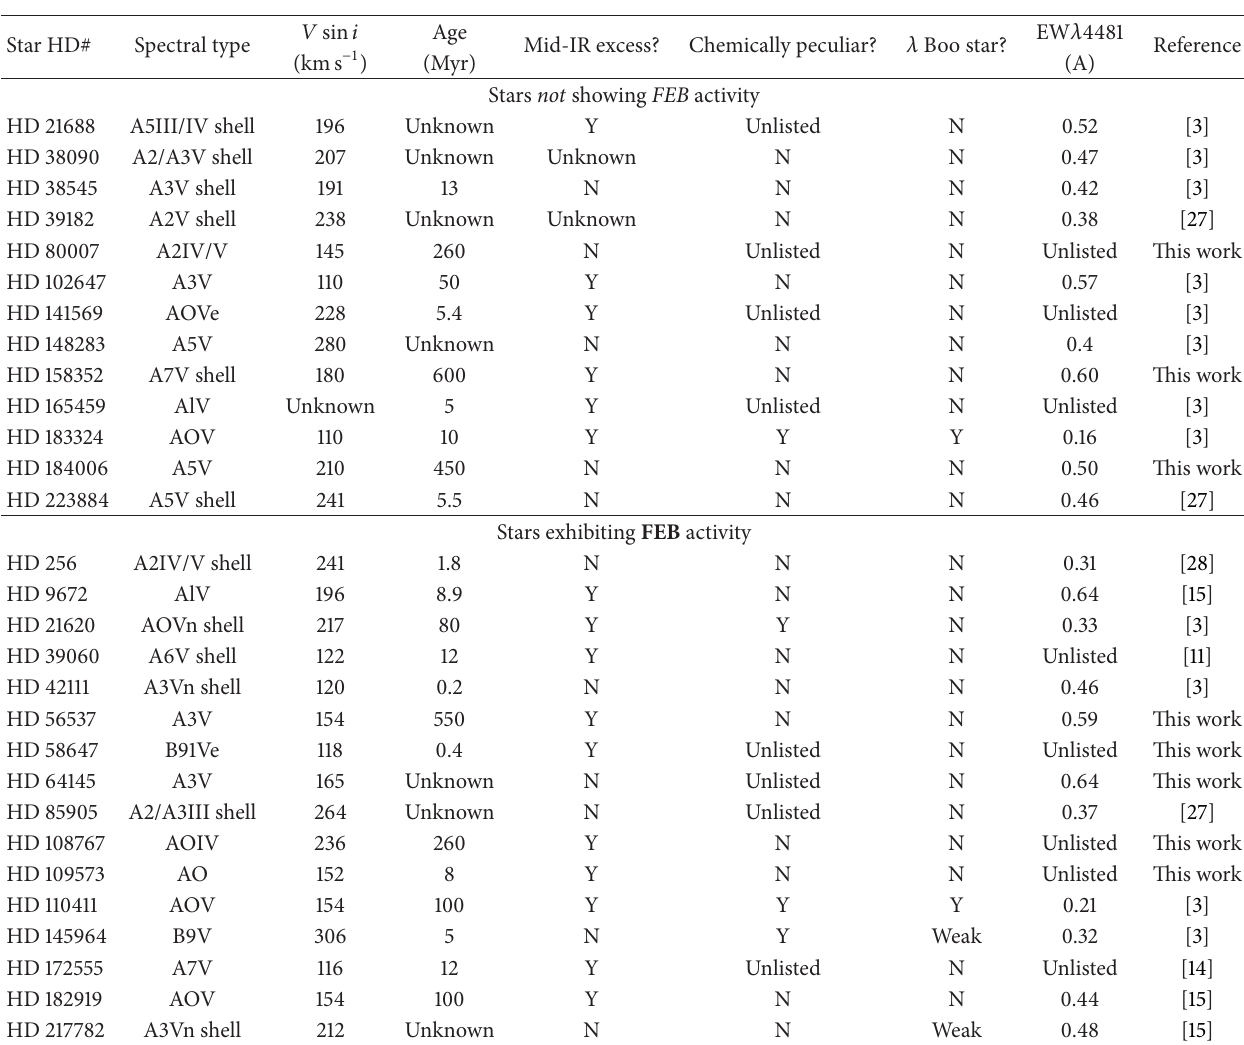
Table 4: Physical parameters of A-stars with circumstellar CaII K-line